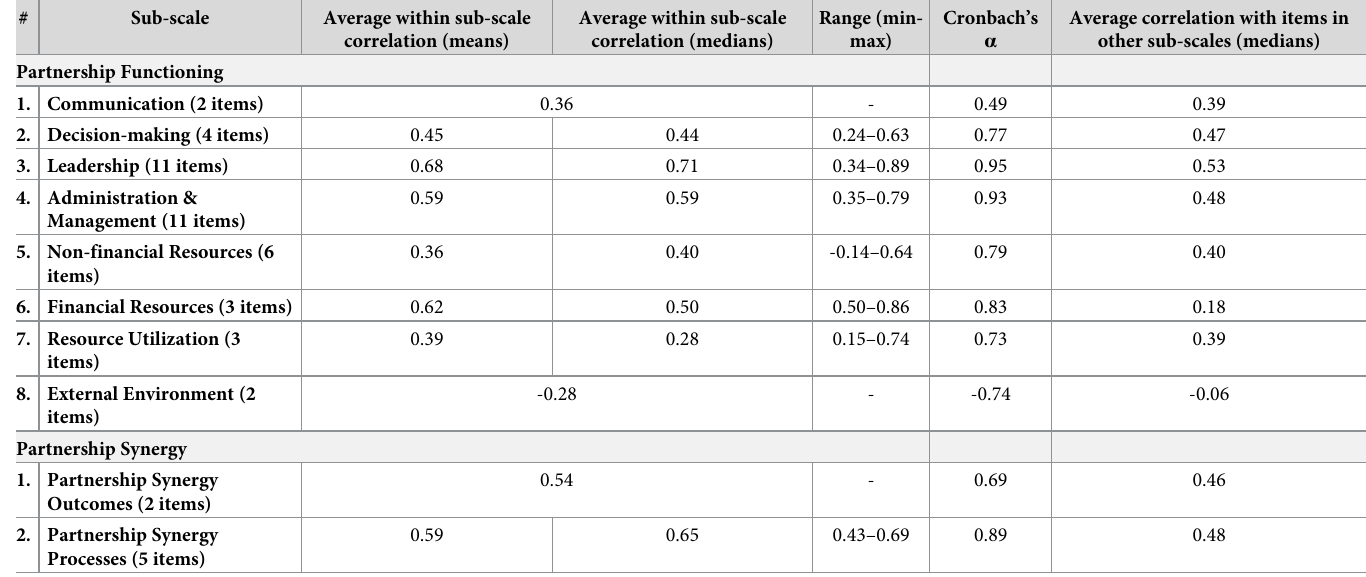
Table 4. Spearman rank correlations between items within each of the sub-scales and between sub-scales of dimensions of partnership functioning and partnership synergy, showing the average, minimum and maximum correlation coefficients, and a measure of internal consistency ( N = 54). # Sub-scale